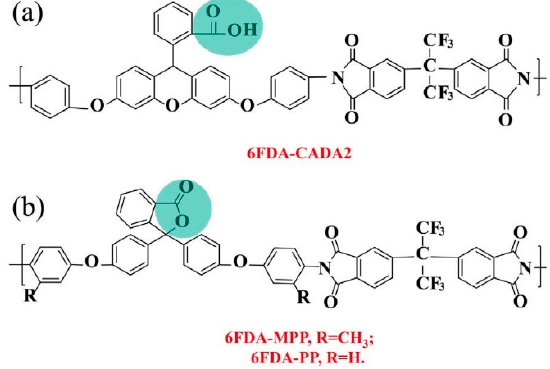
Figure 7. Chemical structures of ( a ) 6FDA-CADA2 [26], and ( b ) 6FDA-MPP, 6FDA-PP [59].